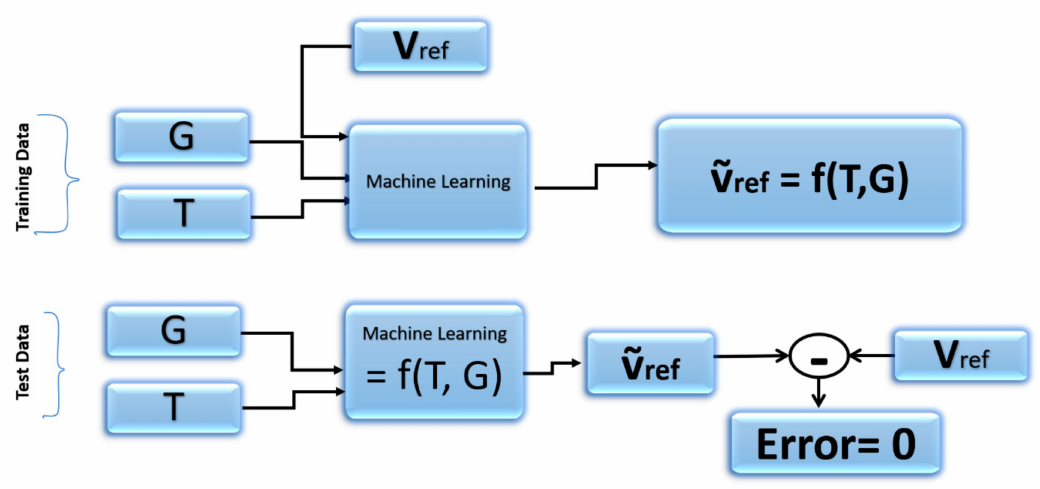
Figure 2. Learning and Running Stages of the Machine Learning Algorithms.